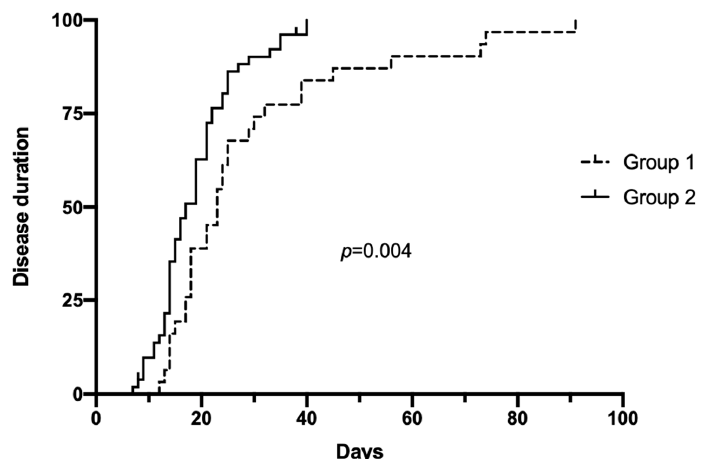
Figure 3. Kaplan–Meier curves for COVID-19 duration (evaluated as time from diagnosis to SARS- CoV-2 PCR negativization) in hemodialysis patients affected by COVID-19 during the first pan- demic waves and the last wave of 2021. Group 1, from March to December 2020; Group 2, from September 2021 to February